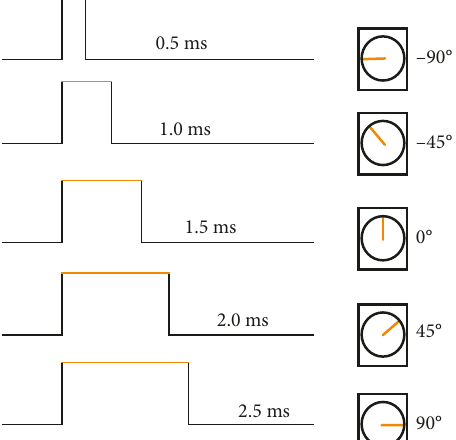
Figure 13: The corresponding relationship between the rotation angle and the PWM signal.